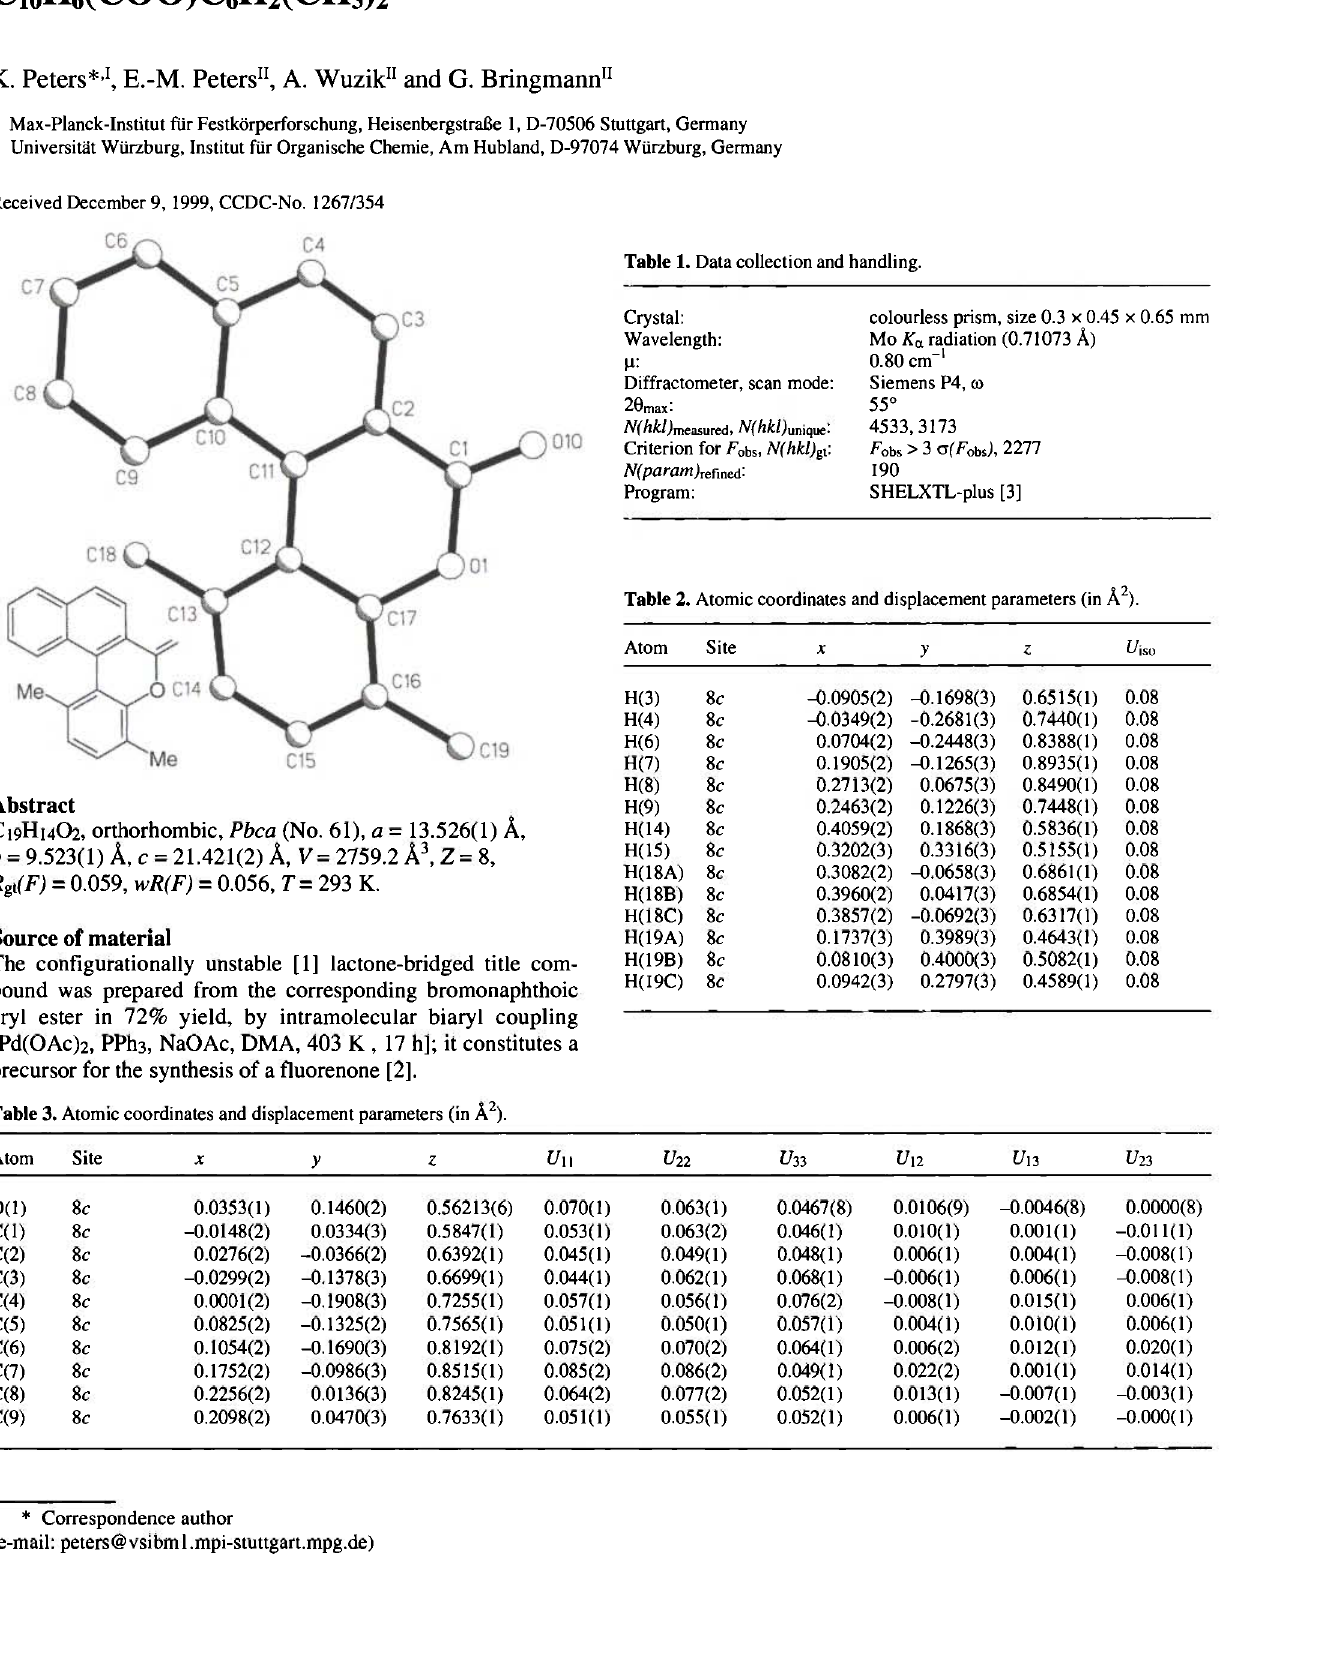
Table 1. Data collection and handling. Crystal: